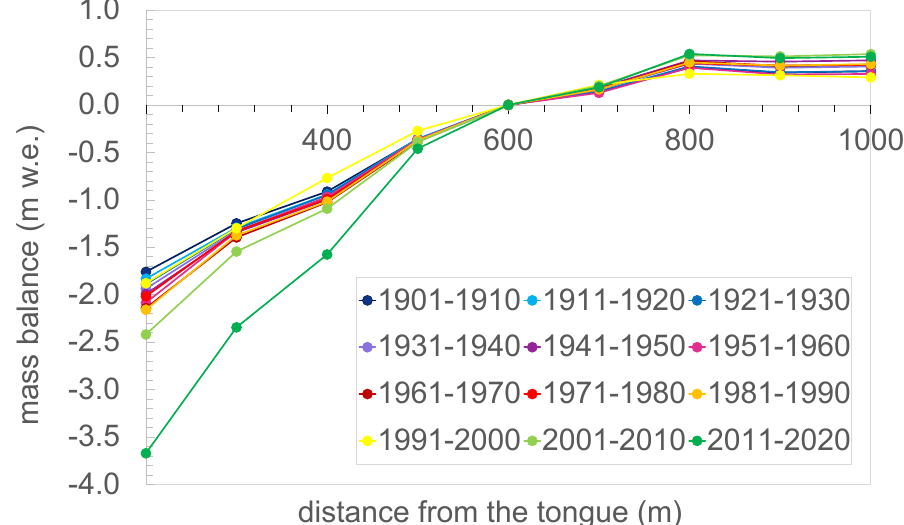
Figure 8. Reconstructed mass balance gradients of Golubin for 10-year periods from 1901 to 2020 adjusted to a fixed ELA 0 at